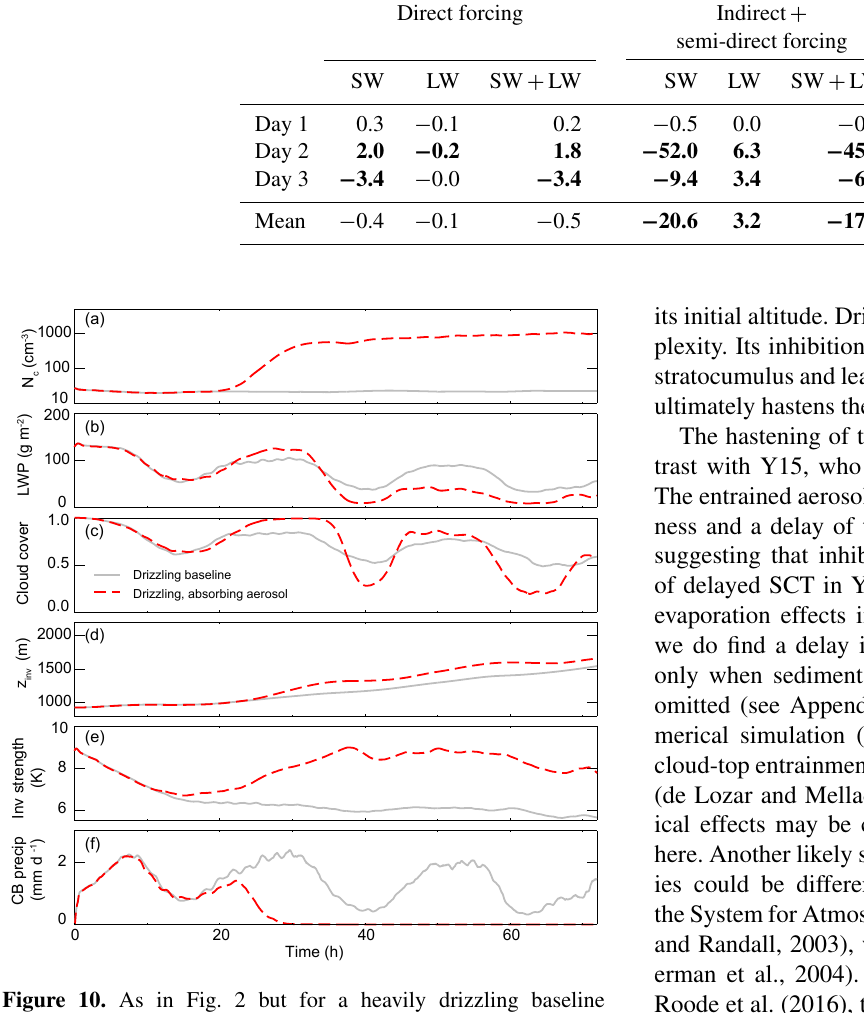
Figure 10. As in Fig. 2 but for a heavily drizzling baseline ( N a , sulfate = 25mg − 1